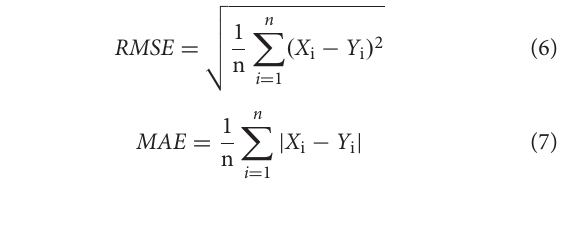
TABLE 1 | The annual average RGCV and RMSE of the six test experiments [Ax (Bx) is the x th experiment for Group A (B)]. Experiments Model